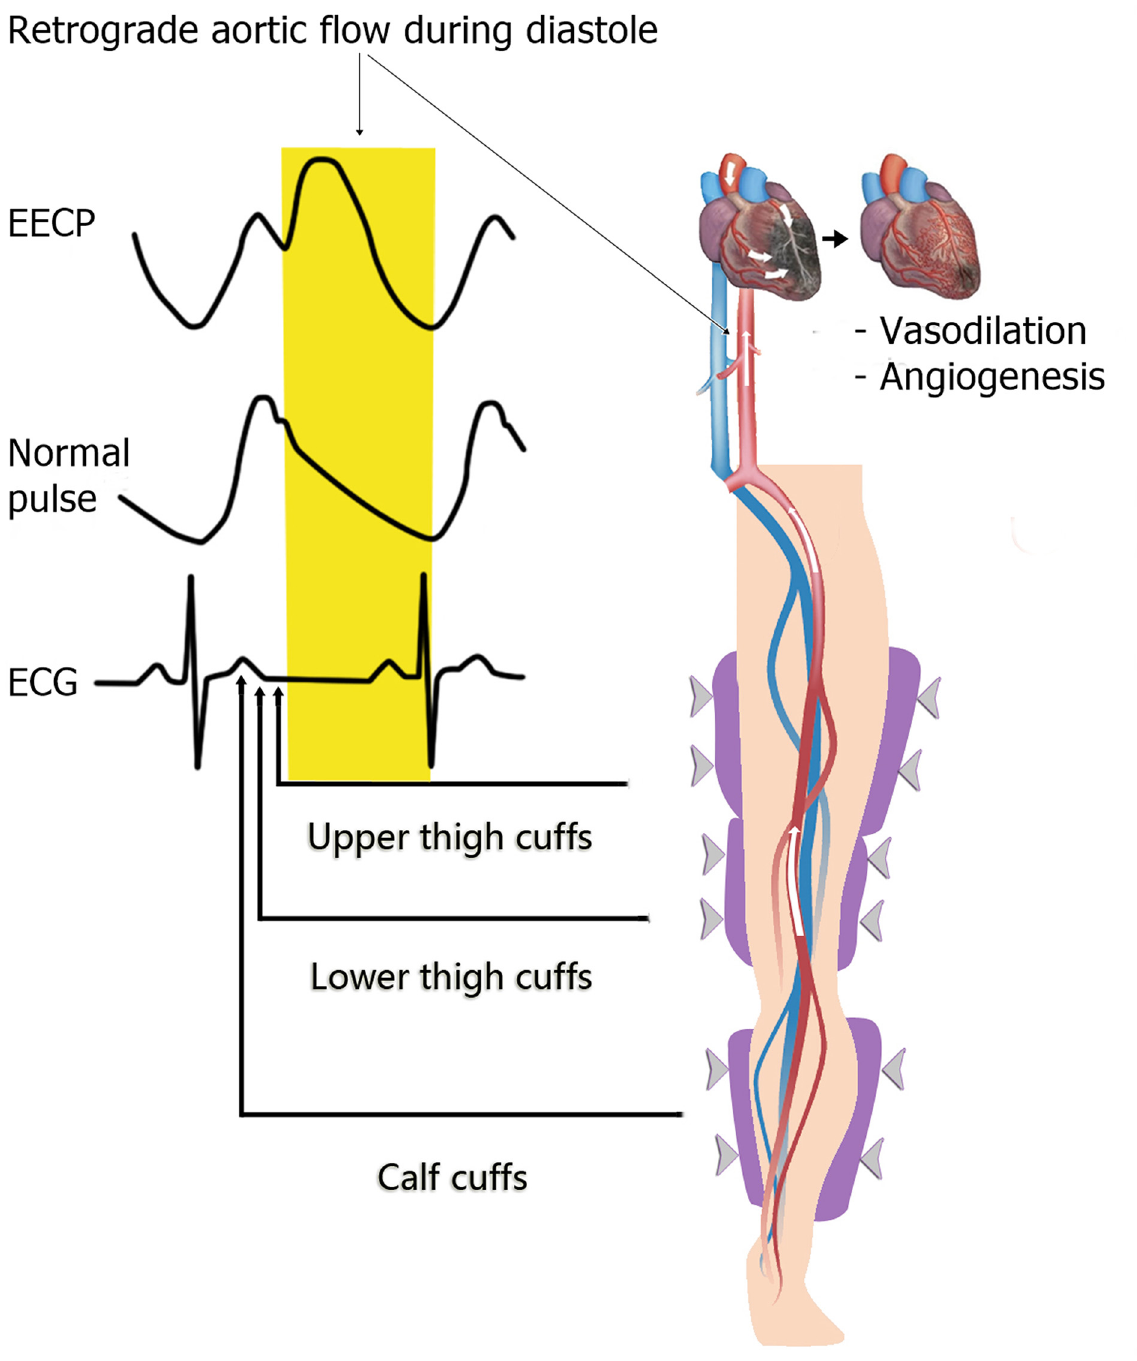
Fig 4. Putative Physiological Mechanisms underlying EECP ’ s Effects on Myocardial Perfusion. EECP produces a diastolic retrograde aortic flow that enhances coronary artery mean pressure and peak diastolic pressure. This retrograde aortic flow acts to improve coronary vasodilation and angiogenesis through three putative mechanisms. First, through its pressure wave, EECP directly vasodilates existent vessels in the myocardium. Second, EECP increases de novo collateral vessel formation through promoting the release of angiogenic and vasoactive factors such as α -actin, von Willebrand factor (vWF), vascular endothelial growth factor (VEGF), basic fibroblast growth factor (BFGF), and hepatocyte growth factor (HGF). Third, EECP increases shear stress in the vasculature, a process which promotes the release of the angiogenic vasodilator nitric oxide (NO).